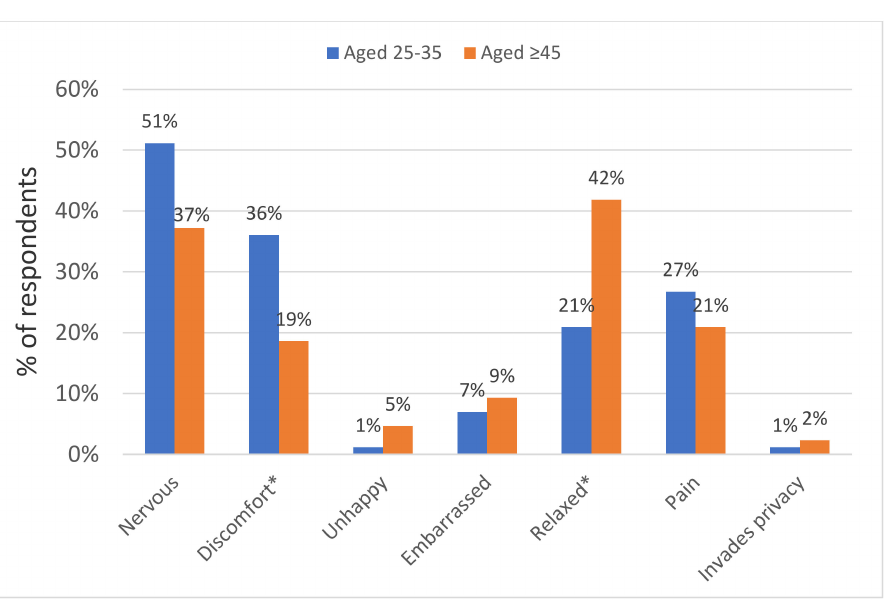
Figure 2. Feelings towards HPV self-sampling after the sampling procedure among the two age groups. % was calculated based on women who scored 4 or above on the Likert scale from 1—strongly disagree to 5—strongly agree. There was a total of 86 participants in the group aged 25–35 (1 missing value in invades privacy dimension) and a total of 43 participants in the group aged ≥ 45. Chi-square / Fisher exact tests were used to compare the di ff erences among the two age groups; * p -value <